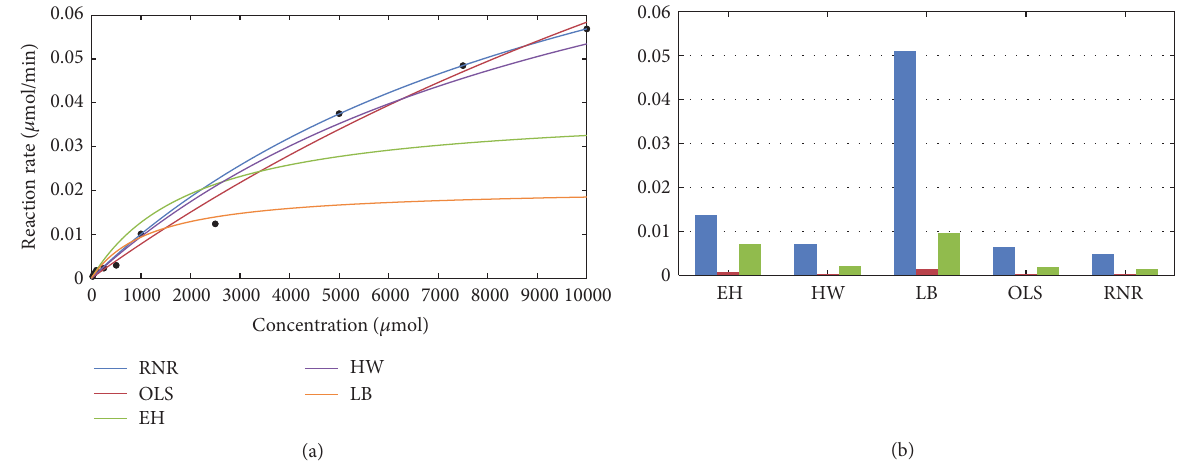
Figure 8: Curves fitted using different fitting techniques for tyrosinase extracted from potato (a). Mean absolute errors for different regression models used